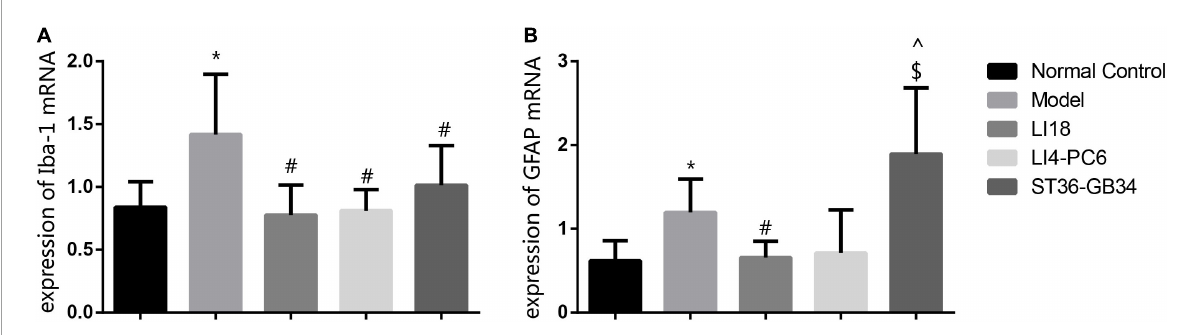
FIGURE4 Effect of electroacupuncture (EA) intervention on ionized calcium-binding adapter molecule 1 (Iba-1) mRNA (A) and glial fibrillary acidic protein (GFAP) mRNA (B) of dorsal spinal cord (C2–C5) at 24 h after neck incision (mean ± SD, n = 8/group). The expression levels of Iba-1 mRNA and GFAP mRNA were significantly upregulated in the model group (vs. the control group), that of Iba-1 mRNA was obviously downregulated in the three EA groups (vs. the model group), and that of GFAP mRNA was obviously downregulated in the EA LI18 group but not in the EA PC6-LI4 and EA ST36-GB34 groups (vs. the model group). * P < 0.01, vs. the control group, # P < 0.05, vs. the model group, ˆ P < 0.05, vs. the EA LI18 group, $ P < 0.05, vs. the EA LI14-PC6